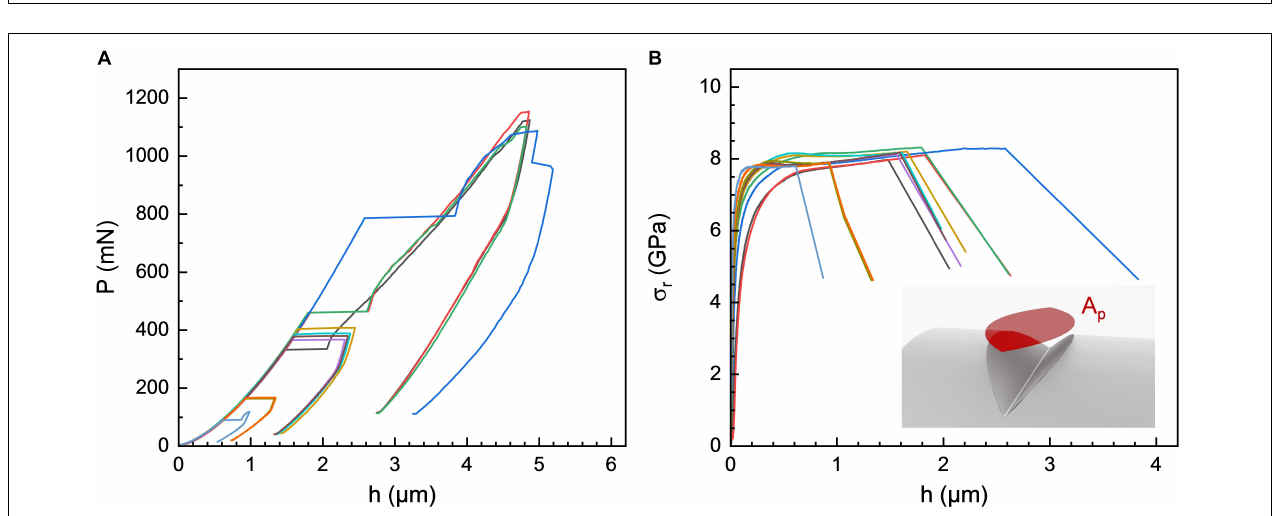
FIGURE 6 | (A) Representative load-displacement P - h curves as recorded from nanoindentation experiments on a 220 µ m silica glass fiber using a wedge-shaped tip with an opening angle of 60 ◦ and an effective length of 180 µ m. The sudden displacement burst at around 405 mN indicates the onset of fracture (green curve). In this case, multiple serrations occur upon unloading (green curve, inset). Corresponding optical micrographs of residual imprints are provided in (B) for the crack-free indent with a maximum load of 490 mN (blue curve), and (C) for the cracked specimen with a maximum load 405 mN (green curve).